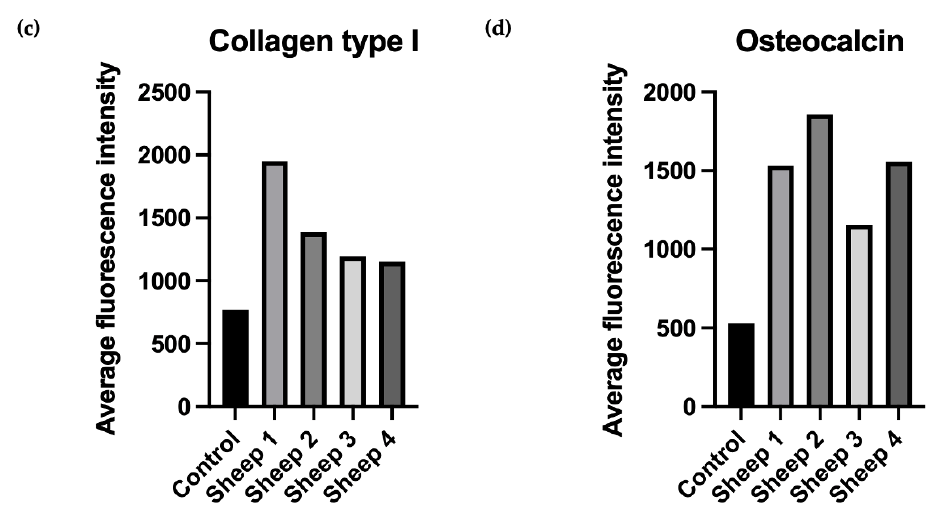
Figure 10. Immunofluorescence analysis of the early osteogenic marker collagen type I ( a ) and late osteogenic marker osteocalcin ( b ) for scaffold sections retrieved from sheep 6 months after the implantation of a scaffold and BM-MSCs treated with FGF-2 or FGF-2 and BMP-2. Merged: DAPI staining of the nucleus (blue) and antibody staining (green fluorescence). Intensity of fluorescence of collagen type I ( c ) and osteocalcin ( d ) compared to negative controls. 3.11. Cytokine Profile of the Sheep Serum after BM-MSC-Scaffold Grafting